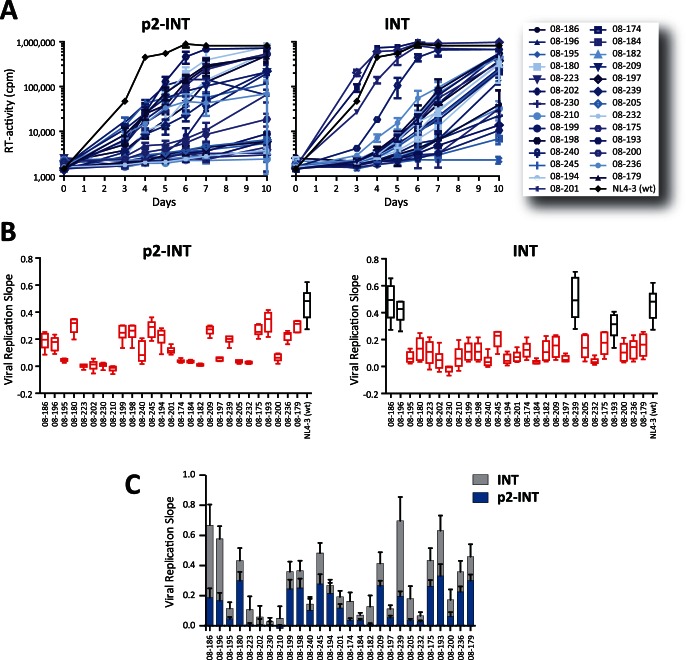
Viral growth kinetics of multidrug-resistant p2-INT- and INT-recombinant viruses in the absence of drug pressure.(A) Twenty-eight p2-INT-recombinant viruses (i.e., 27 INSTI-resistance and the HIV-1NL4-3 wild-type virus) were evaluated for their ability to replicate in MT-4 cells in the absence of drug pressure. Virus replication was quantified by measuring reverse transcriptase (RT) activity in the cell-free supernatant. Error bars indicate the range of values obtained from three independent experiments. (B) Viral replication slopes were calculated using the slopes between RLU values as described in the legend of Figure 3. (C) Comparison of the mean viral replication slope between p2-INT and INT-recombinant viruses constructed from the same HIV-infected individual.